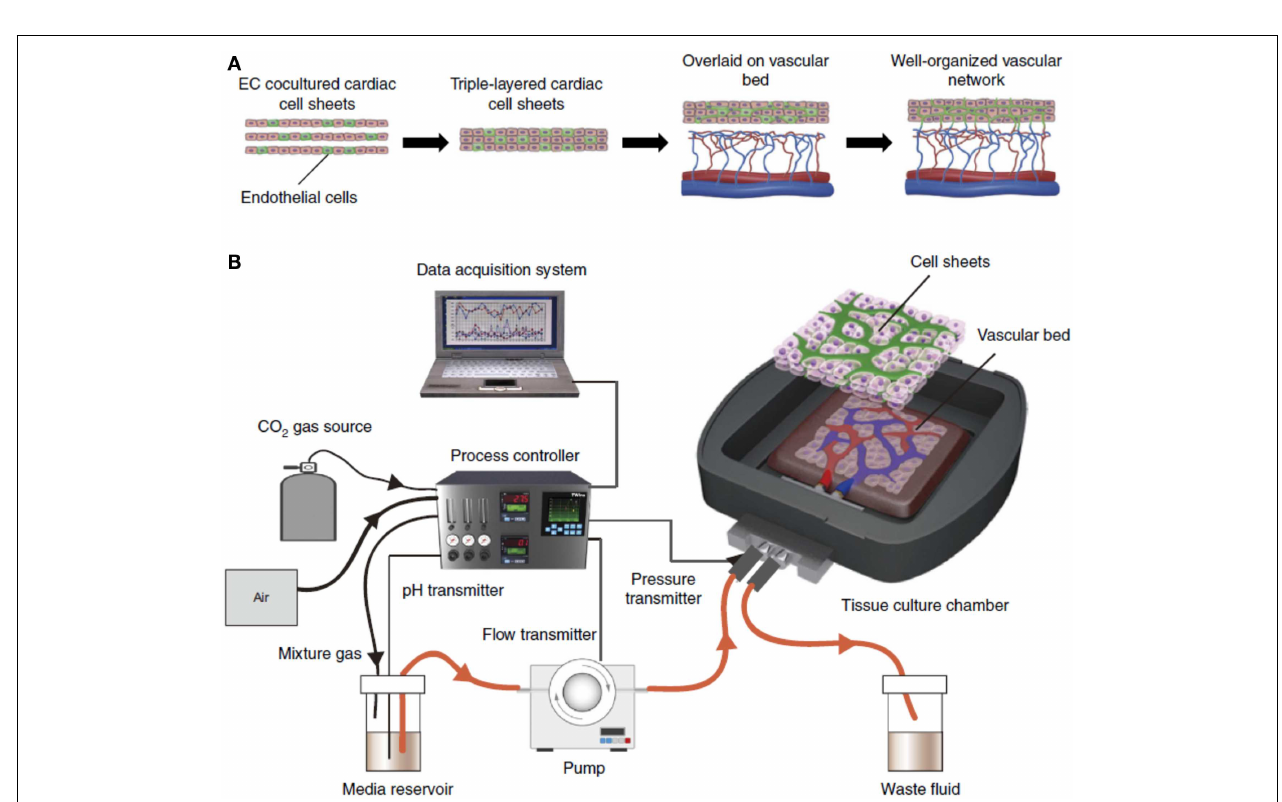
vessels that originated from the vascular bed. Finally, the cell sheet constructs survive via the media supplied through the new vessels formed in vitro . (B) The engineered constructs are perfused in a custom-made bioreactor. Adapted by permission from Macmillan Publishers Ltd.: (Nature Medicine) (Sekine et al., 2013), copyright